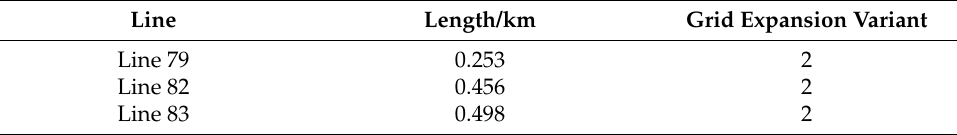
Table 19. Results of the cable dimensioning for the planning variant combining underground cables and BSS.